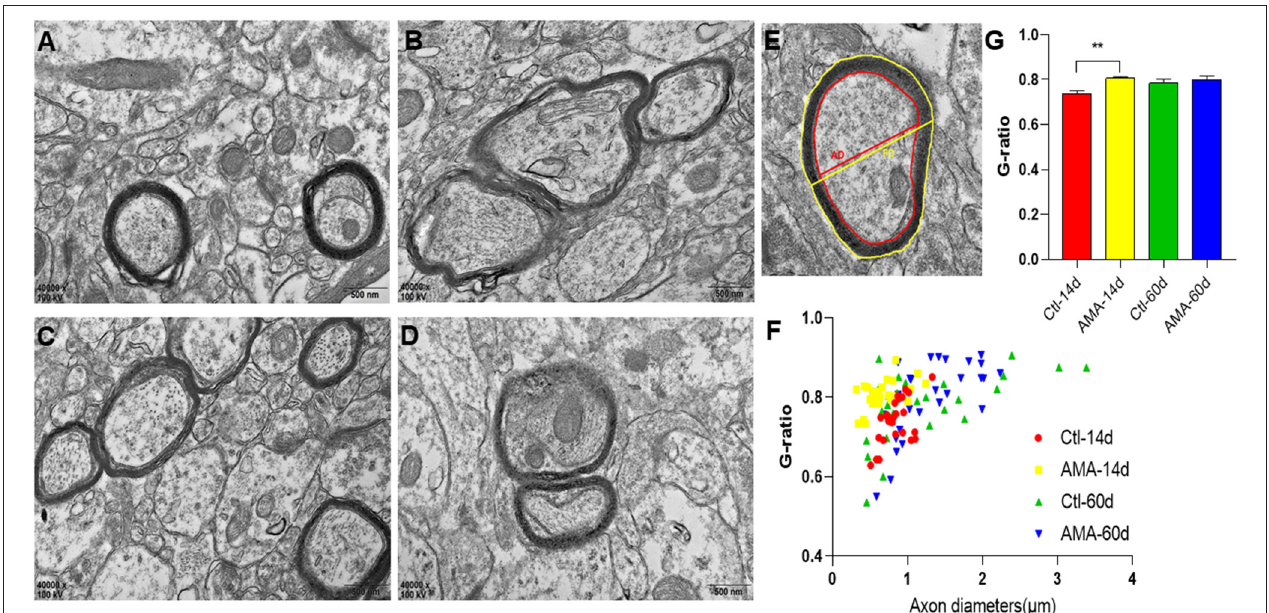
FIGURE 4 | Ultrastructural Changes to Myelin Sheath in the AMA and control groups. (A) Representative transmission electron microscopy images of the ultrastructure of myelinated fibers in the hippocampi of rats in the Ctl and (B) AMA groups on P14. (C) Transmission electron microscopy revealed the ultrastructure of myelinated fibers in the hippocampi of rats in the Ctl and (D) AMA groups on P60 ( × 40,000, scale: 500nm). (E) Examples of the measurements used for the analysis of the g-ratio. (F,G) Quantification of the myelinated g-ratio in the AMA and control groups. ** p < 0.01, n = 3 rats in each group.